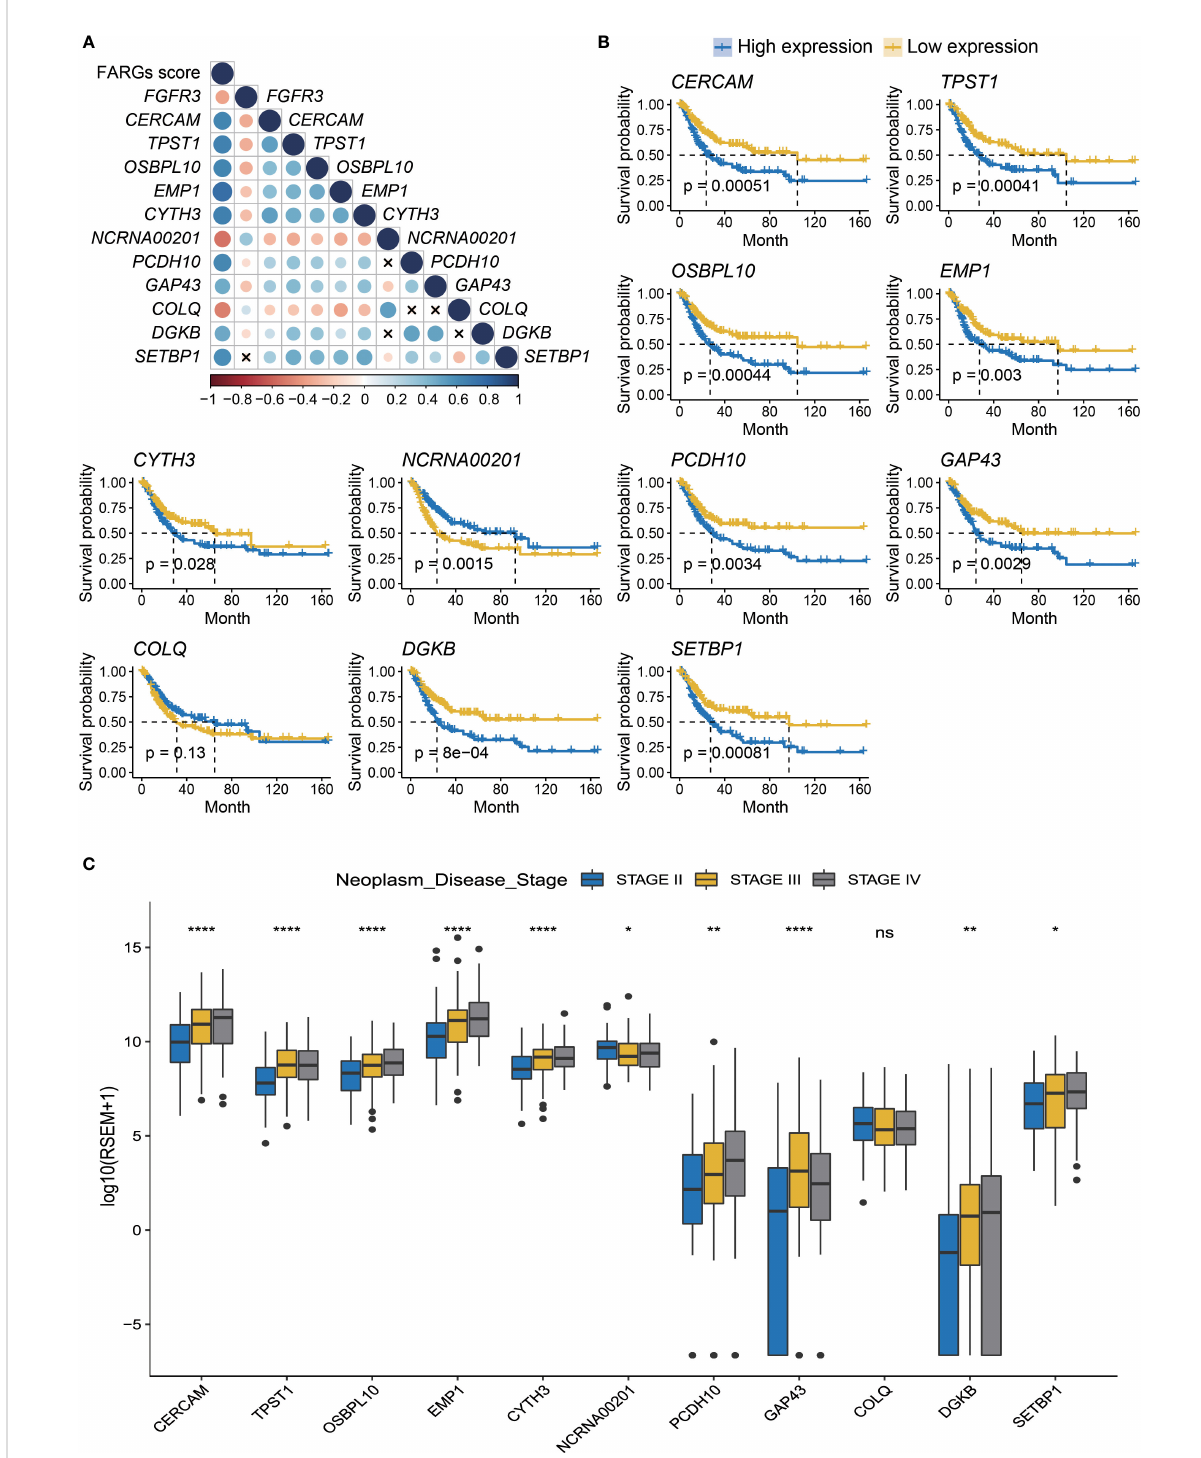
FIGURE 4 The prognostic merits of 11 FARGs involved in the signature. (A) The correlation analysis of FGFR3 expression and 11 signature-related FARGs ( CERCAM , TPST1 , OSBPL10 , EMP1 , CYTH3 , NCRNA00201 , PCDH10 , GAP43 , COLQ , DGKB , and SETBP1 ) at the transcriptional level (× indicated correlations were not signi fi cant). (B) The Kaplan – Meier curve analysis for BC patients with high and low expression of these 11 signature- related FARGs. (C) The comparison of expression of 11 signature-related FARGs between BC patients in different neoplasm disease stages. * indicated p < 0.05, ** indicated p < 0.01, **** indicated p < 0.0001, ns indicated no statistically signi fi cant